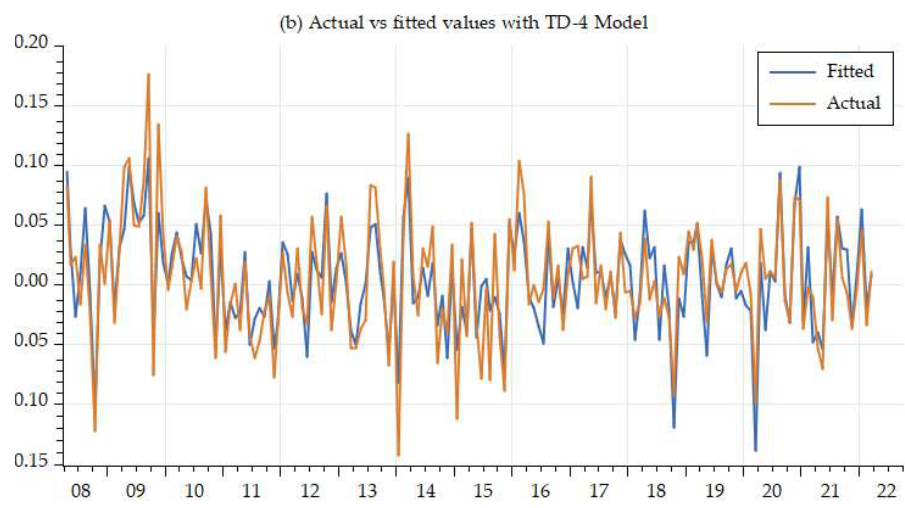
Figure 2. Actual vs. fitted values with the local CAPM and TD-4 models.